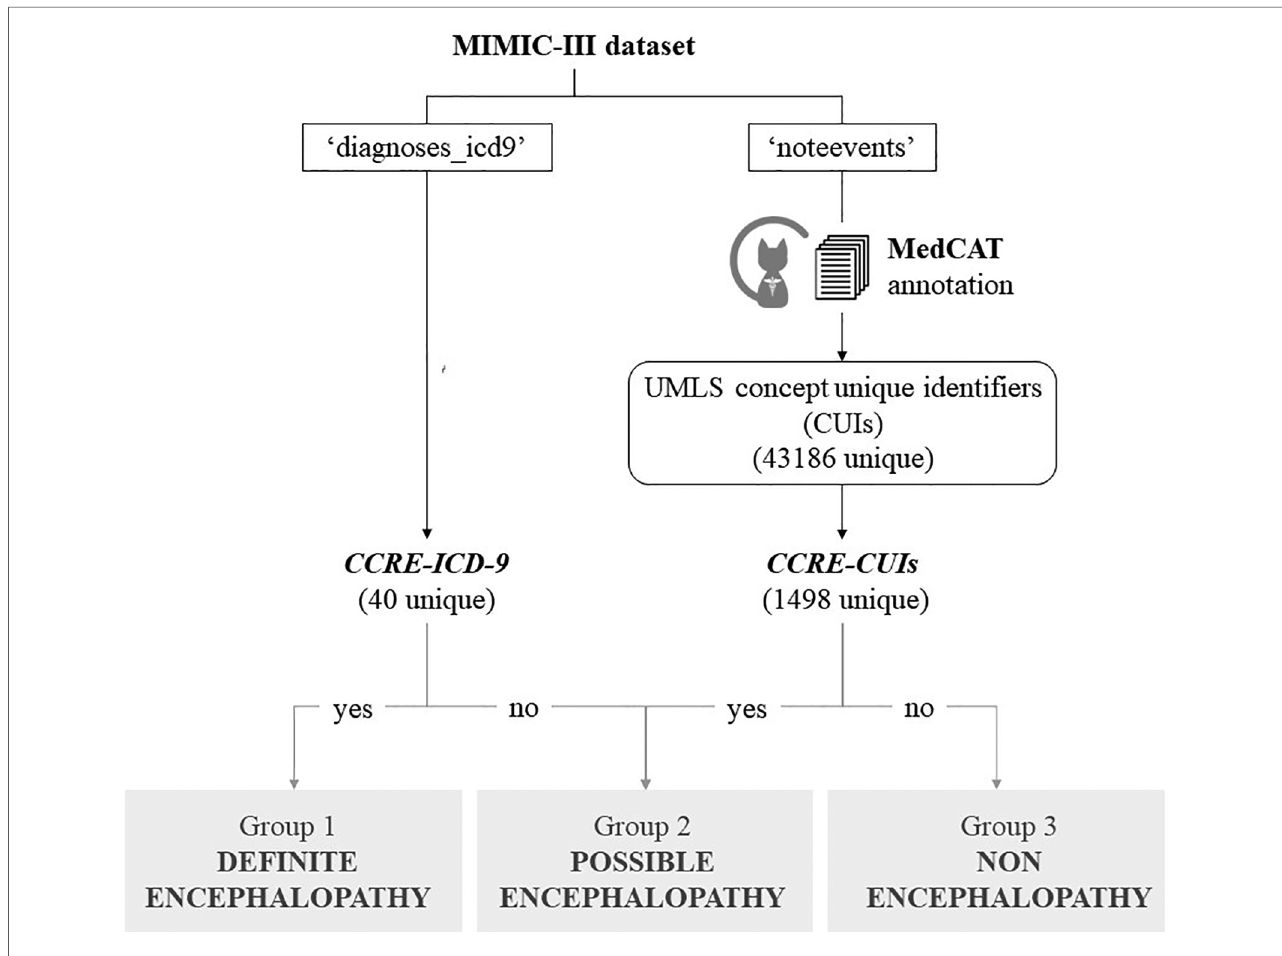
FIGURE 1 Cohort de fi nition. Flowchart representing the classi fi cation of patients from MIMIC-III dataset, based on their encephalopathy status. Groups 1+3 were used as positive/negative label to train the model in a binary classi fi cation task. The best model was applied to unseen cases with possible